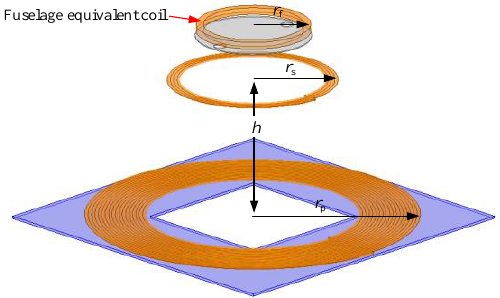
Figure 12. Equivalent model of carbon fiber fuselage.